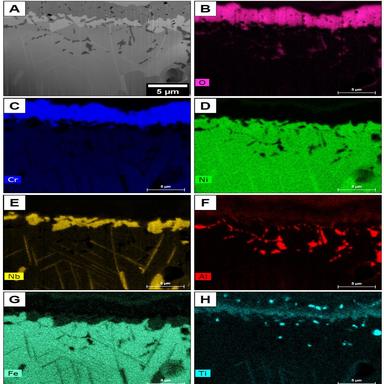
(A) Cross-sectional SEM-BSE image of the near-surface microstructure of the 718Plus superalloy oxidized at 850 °C for 1000 h, based on the last slice during the serial sectioning procedure. (B–H) Corresponding SEM-EDXS distribution maps of selected elements, acquired after the serial sectioning procedure.